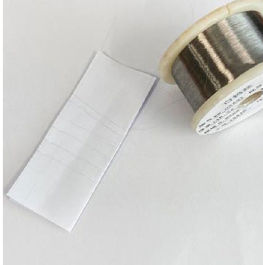
Figure 1. Tungsten wire (50 μm) used in the manufacture of the shielding